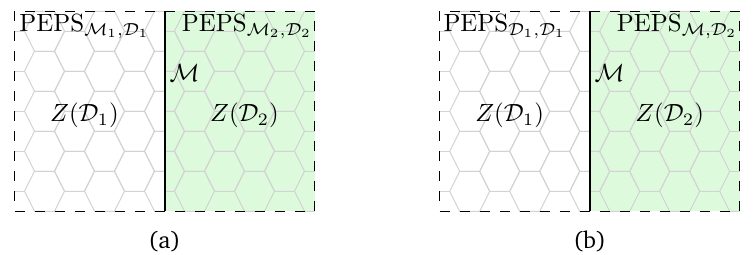
and D , described 1 2 = D 1 1 ) - , D 1 2